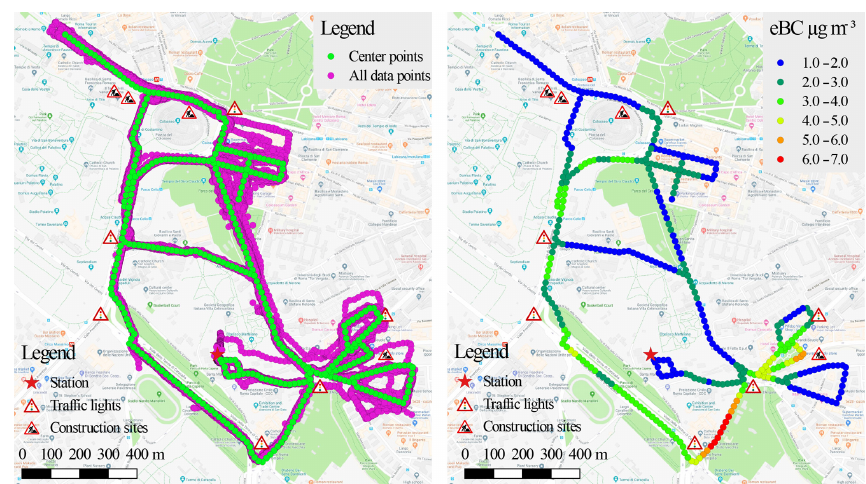
Figure 5. Illustration of the spatial averaging performed on the mobile measurement data (a) showing all the data points in purple dots and the center points for averaging in green and (b) with the spatial average of eBC mass concentrations for the entire campaign. Map data © Google Maps